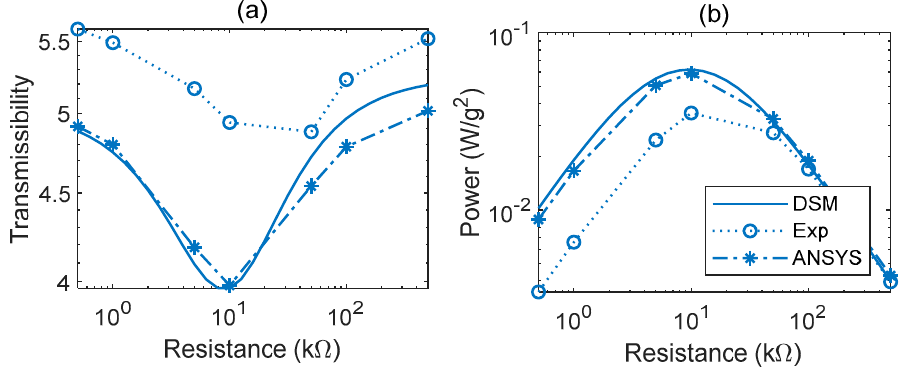
Figure 13. Variations of peak magnitude of the transmissibility FRF ( a ) and power FRF ( b ) with load.